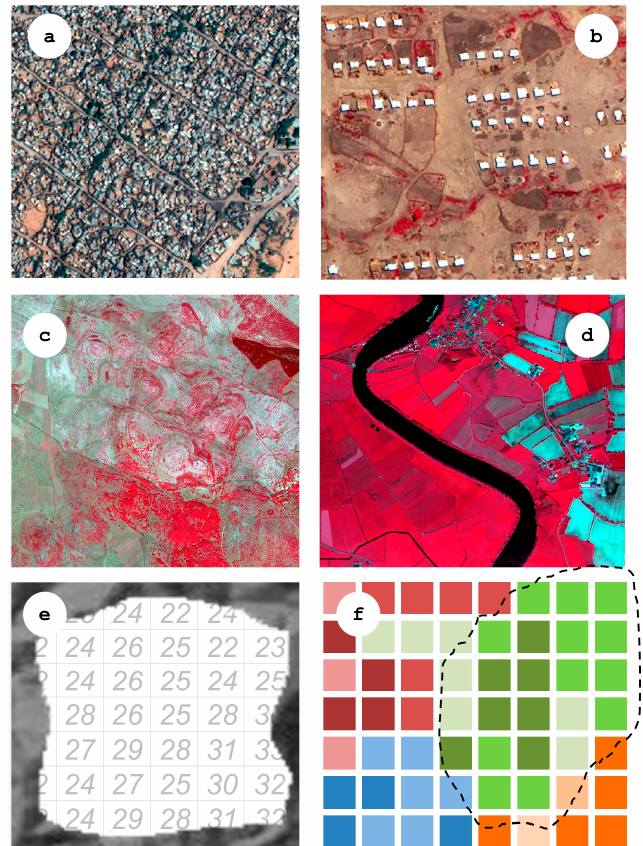
Figure 5. Scene complexity and spatial autocorrelation: two image pairs with different levels of complexity, despite pair-wise similar semantic content, scale and being captured by the same sensor (Worldview-2). ( a , b ) Two refugee camps in sub-Saharan Africa; two rural landscapes—( c ) southern Spain and ( d ) northern Germany; ( e ) gradients between homogenous image regions exhibiting high spatial auto-correlation are perceived as boundaries ( f ) corresponding with the key geographic principle of regionalization.